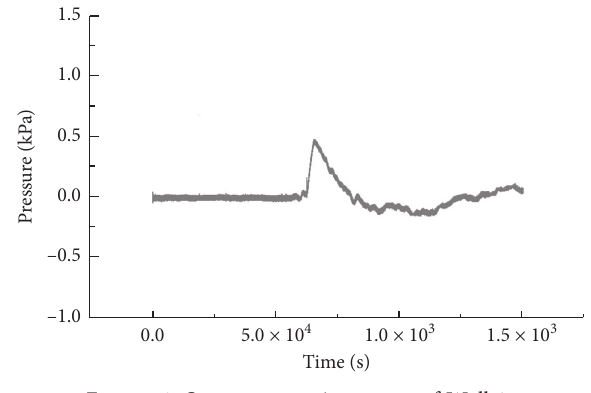
Figure 4: Overpressure–time curve of Wall 9.